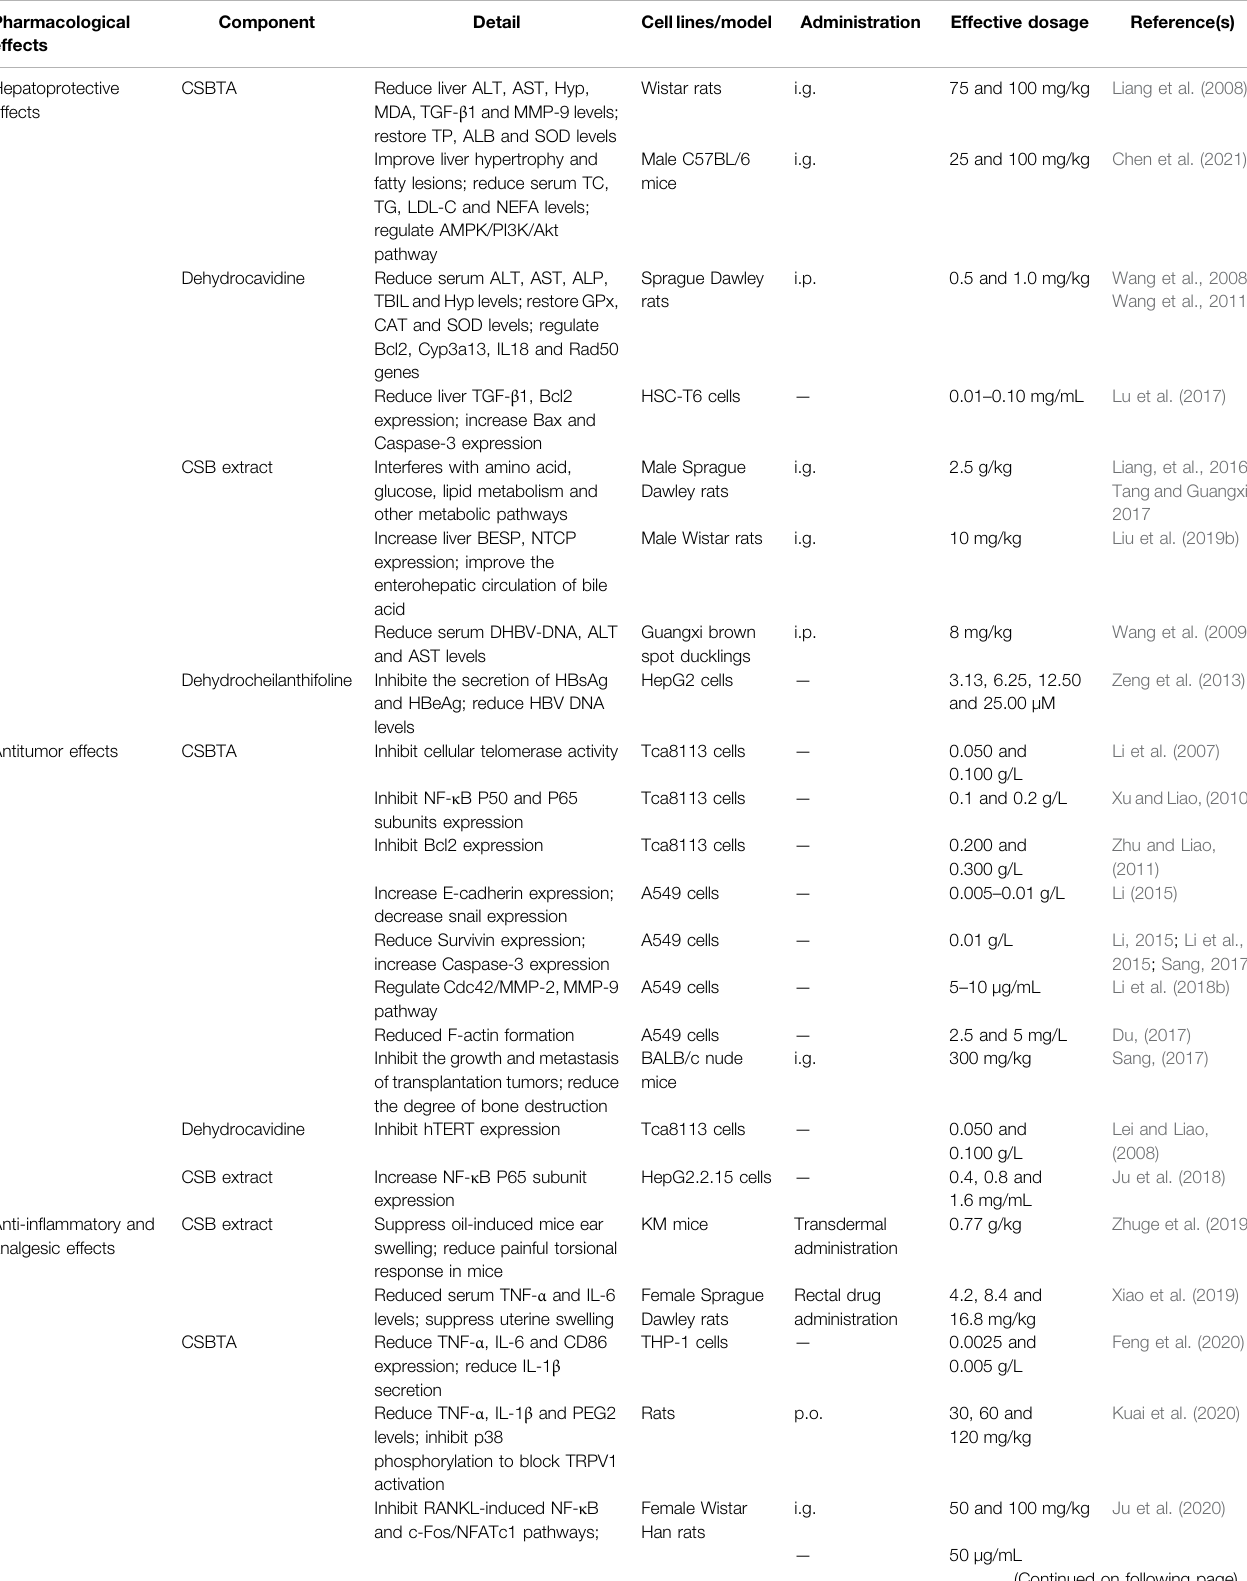
TABLE 3 | The pharmacological effects of